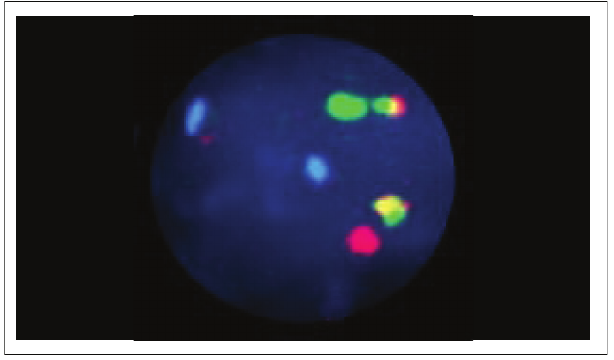
FIGURE 3: Fluorescence in-situ hybridisation analysis of fine needle aspirate from a 9-month-old male patient who presented to the Charlotte Maxeke Johannesburg Academic Hospital in February 2019. Image shows translocation t(8;14)(q24;q32) using the Vysis LSI MYC/IGH/CEP8 tri-colour dual fusion probe, as well as a 2F1O1G2A pattern: 2 fusion, 1 orange, 1 green, 2 aqua signals. The orange, green and aqua signals represent the MYC, IgH and centromere 8